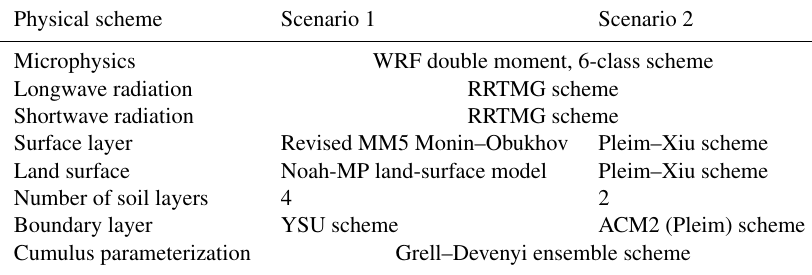
Table 1. WRF parameterization